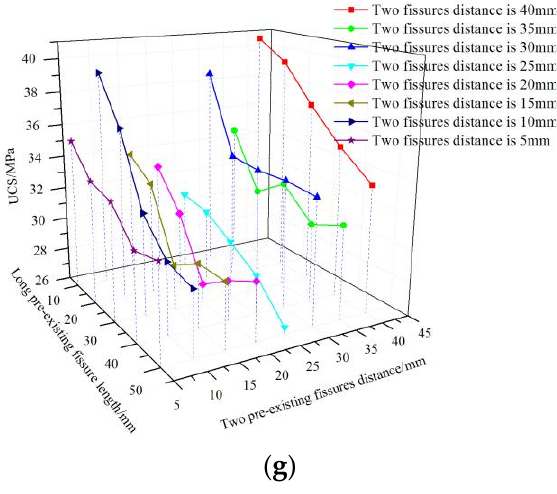
Figure 4. UCS of rock-like materials with a variation in preexisting fissure length. ( a ) Fissure angles of 0° ( b ) 15°; ( c ) 30°; ( d ) 45°; ( e ) 60°; ( f ) 75°; and ( g ) 90°.